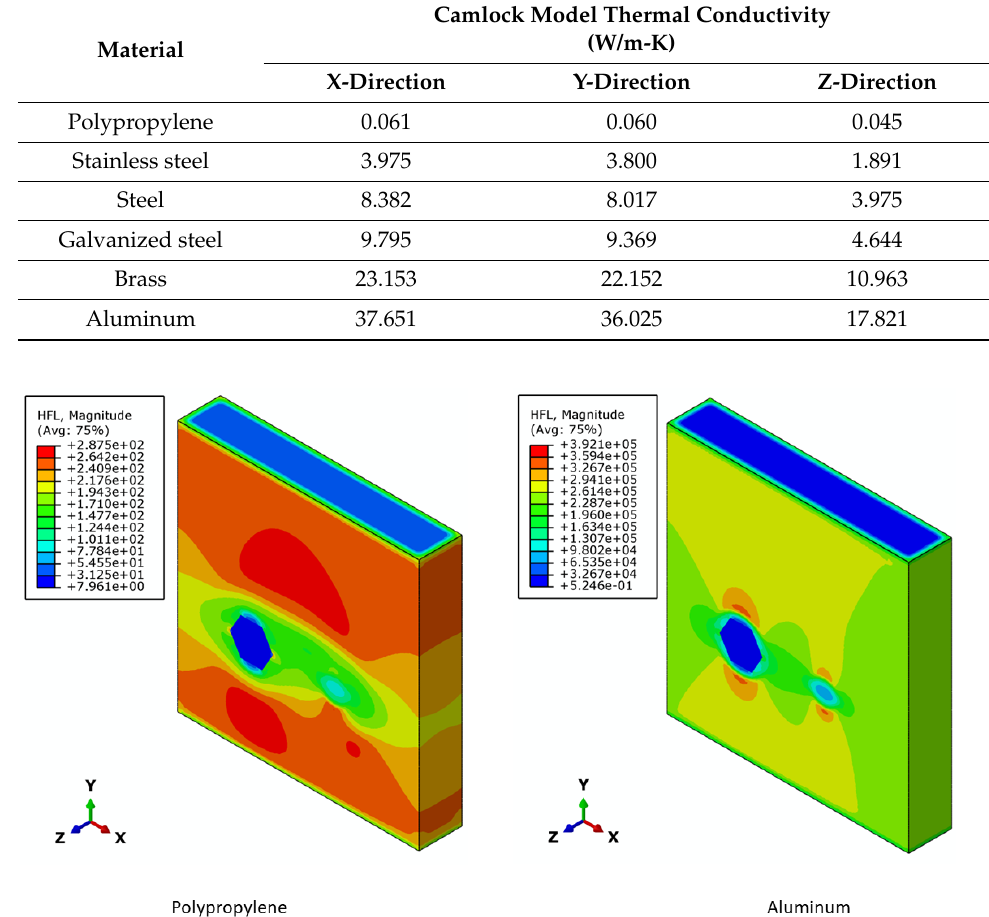
Figure 5. Heat flux in the X-direction of the camlock model with different materials.